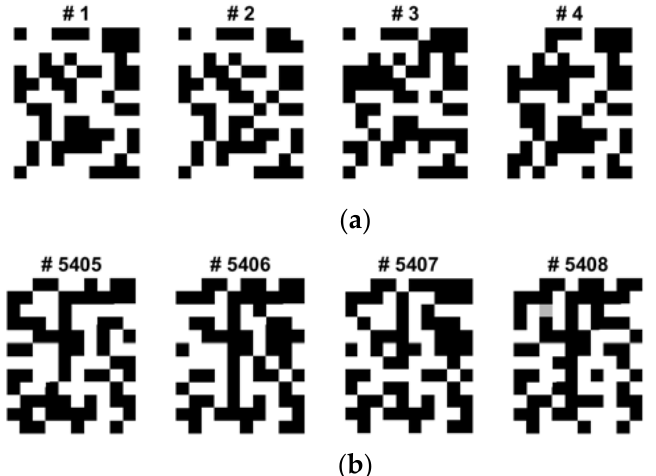
10 of 18 Figure 7. An original eigenface images of subjects for training data for 4 classes: left, right, feet, and tongue after whitening (12 × 10: = 30 × 4) in C3D3a_4C. Thus far, we obtained the training coefficients by projecting the training images to the QR-eigenfaces and testing the coefficients by projecting the testing images to the QR- eigenfaces. The next step is to conceive of new QR images for training and testing the dataset. Subsequently, linear combinations of the QR eigenfaces, weighted by the rele- vant coefficients, were used as QR images for training and testing data. During the data augmentation process for overcoming the limited dataset problem in the BCI competition, we modified the brightness of the recovered images based on the